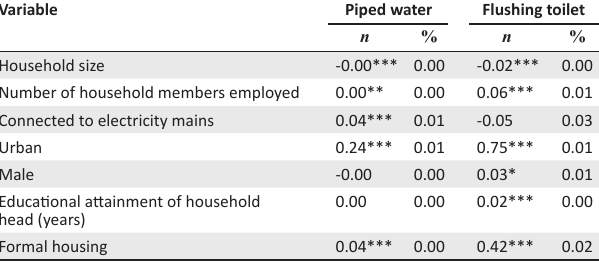
TABLE 4: African household socio-economic drivers of access to piped water and flushing toilet.